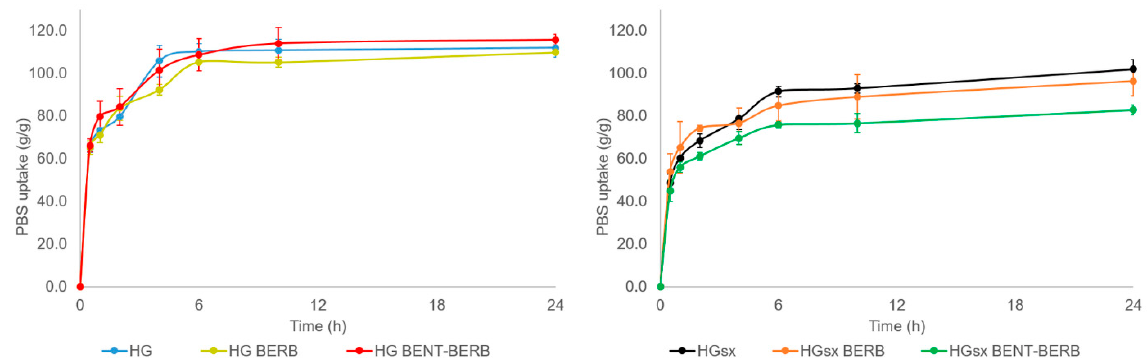
Figure 2. Hydrogels swelling performances. Evaluation of water uptake relevant to HG-based (left panel) and HG sx -based (right panel) hydrogels performed at 32 °C up to 24 h in PBS.